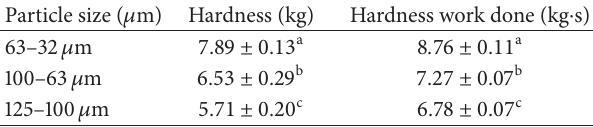
Table 3: Effect of particle size on instrumental spreadability